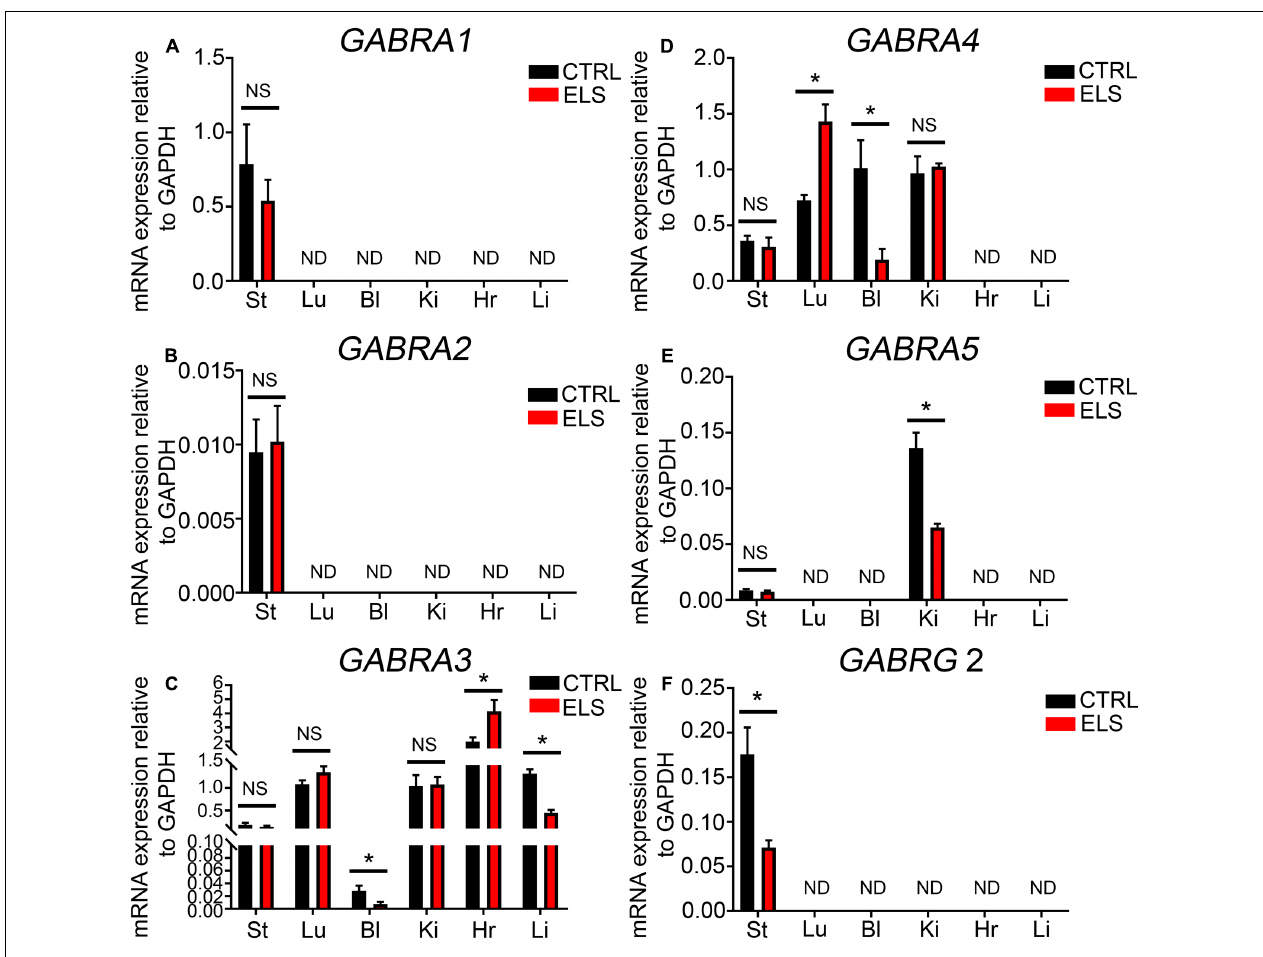
FIGURE 4 | Early life stress (ELS)-induced changes in the level of GABA A R subunit mRNA expression within various peripheral organs. Quantification of the ELS-induced changes in the expression levels of the (A) α 1-GABA A R subunit mRNA, (B) α 2-GABA A R subunit mRNA, (C) α 3-GABA A R subunit mRNA, (D) α 4-GABA A R subunit mRNA, (E) α 5-GABA A R subunit mRNA, and (F) γ 2-GABA A R subunit mRNA, within mouse stomach (St), lung (Lu), bladder (Bl), kidney (Ki), heart (Hr), and liver (Li) tissue, relative to the housekeeping gene GAPDH, using qPCR. Note that the mRNA expression of some subunits, relative to GAPDH, was not always detectable (ND) using qPCR. Data represent mean ± SEM; N = 5 animals. NS, not significant. Student’s unpaired t -test. ∗ P <